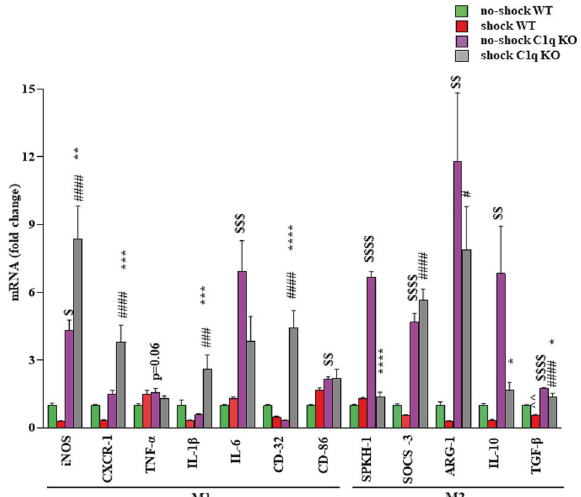
Fig. 5 Shock treatment results in increases in macrophage/ microglia M1 markers in the PFC of C1q KO mice. mRNA expression (fold change) of the M1 markers : iNOS. Two-way ANOVA, genotype X treatment interaction (F (1, 22) = 11.34, p = 0.0028, n = 6 – 7); Tukey ’ s multiple comparisons; $ p = 0.0143 vs no-shock WT, #### p < 0.0001 vs shock WT, ** p = 0.0039 vs no-shock C1q KO. CxCR-1. Two-way ANOVA, genotype X treatment interaction (F (1, 22) = 17.22, p = 0.0004, n = 6 – 7); Tukey ’ s multiple comparisons; #### p < 0.0001 vs shock WT, *** p = 0.0008 vs no-shock C1q KO. TNF- α . Two-way ANOVA, genotype X treatment interaction (F (1, 23) = 5.830, p